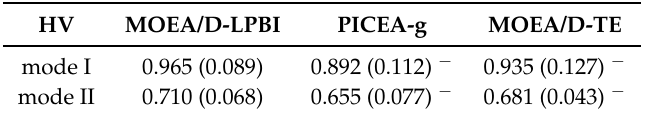
Table 4. The mean HV results and the standard deviations (in the parentheses) of MOEA/D-LPBI, PICEA-g and MOEA/D-TE for HRES. Just as above, their comparable results are marked by “+”, “ − ” or “=”. HV MOEA/D-LPBI